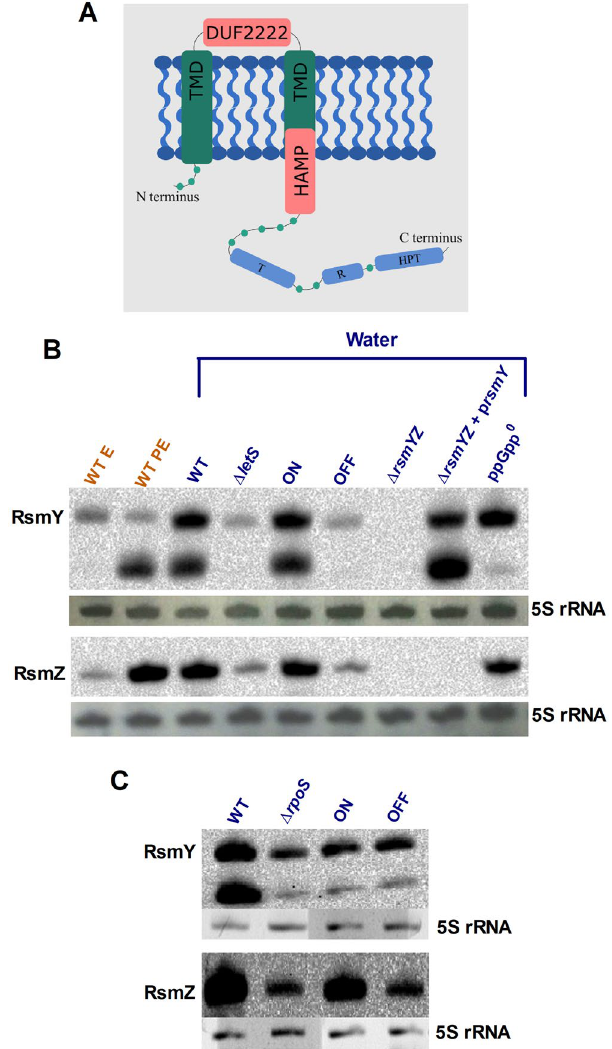
Figure 7. LetS topology and the impact of the stringent response elements, RpoS and ppGpp, on RsmY/Z expression. ( A ) Topology of the LetS protein was determined using the NCBI CDD Web server, as well as TMHMM v.2.0 and TOPCON software. Transmembrane domains (TMD) are represented by green boxes. Two putative signal sensing domains (pink boxes) are also predicted; a DUF2222 domain is located between the two TMD, and a HAMP domain overlaps the C-terminus of the second TMD. The transmitter (T), receiver (R) and phosphotransfer (HPT) domains that are involved in signal transduction are represented by light blue boxes. ( B ) The sRNAs RsmY (top) and RsmZ (bottom) under LetS control were probed to determine their levels in water and the influence of ppGpp on their expression. The first two lanes represent the WT strain grown in rich broth to the exponential (E) or the post-exponential (PE) phase. The remaining wells represent the respective strains exposed to water for 2 hours. ( C ) Impact of RpoS on the expression of RsmY/Z. The sRNAs RsmY (top) and RsmZ (bottom) under LetS control were probed to determine their levels in water. The WT (JR32), rpoS mutant, the induced (ON) or uninduced (OFF) ∆ rpoS + p rpoS strains were exposed to water for 2 hours. 1 μ g of RNA was loaded into each well. Acrylamide gels were stained with ethidium bromide to visualize the 5 S rRNA loading control (shown beneath the respective blots). See Supplementary Figs S5 and S6 for complete gel and blot